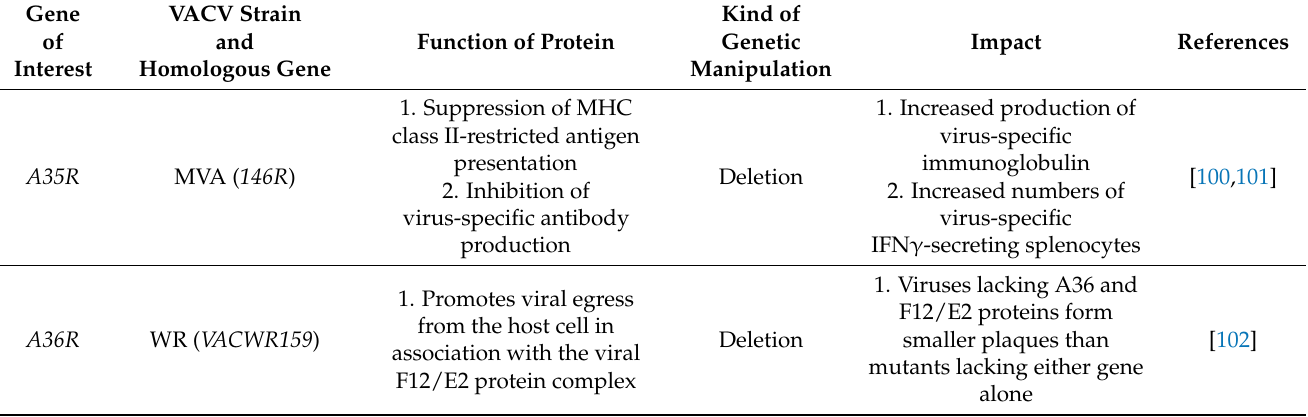
Figure 2. Synopsis of targeted genetic manipulations to improve immunogenicity and vaccine performance of MVA. Genetic manipulation by homologous recombination resulted in either deletion or insertion in the viral genome. Genes separated by a comma (,) have been discretely deleted or inserted. Genes separated by a plus sign (+) have been deleted or inserted in combination. Table 2. Viral genes as targets of genetic manipulation within VACV genomes and their potential impact on vaccine immunogenicity. The “gene of interest” refers to the VACV strain Copenhagen and is depicted according to the Hin dIII fragment letter/ORF number nomenclature used for this strain [39]. Homologous genes for strains WR [40] and MVA [41] are named according to the current nomenclature based on a numerical taxonomy in which the ORFs are numbered consecutively starting from the left to the right end of the genome. Genetic manipulation by homologous recombination resulted in either deletion or insertion in the respective viral genome.